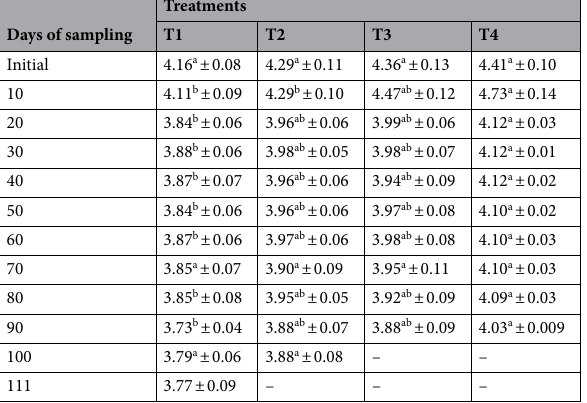
Table 6. Chicken litter biochar on soil pH in KCl at one hundred and eleven days after transplanting of MR219. Different letters within a row indicates significant difference between means of four replicates ± standard error using Tukey’s test at p ≤